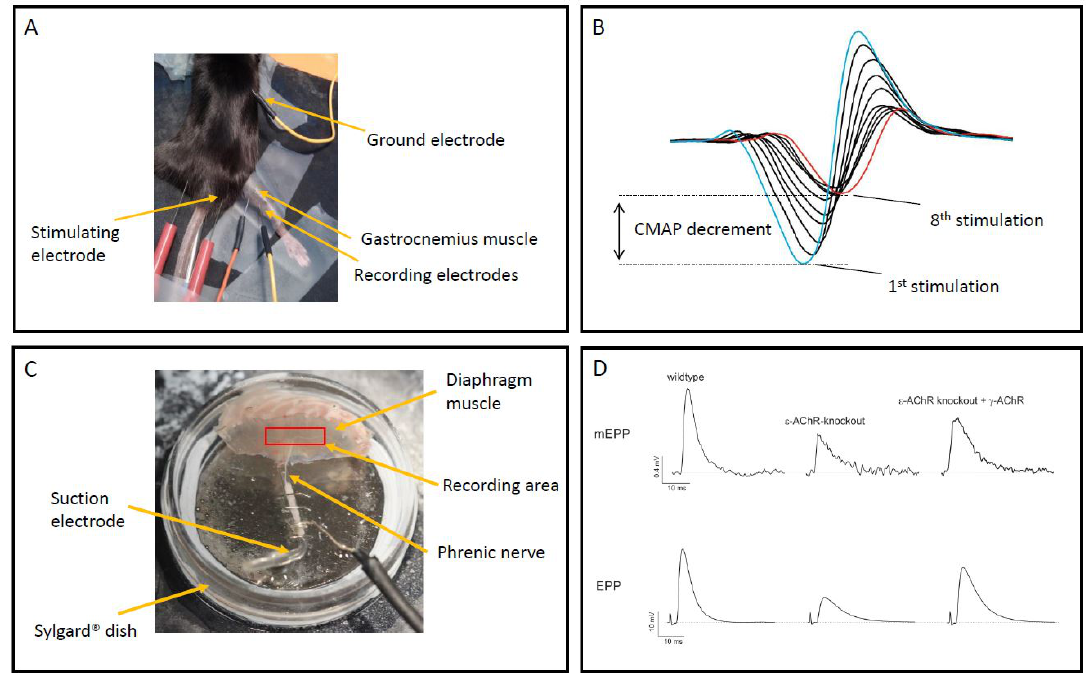
Figure 1. Panel ( A ) shows experimental setup for in-vivo electromyography of anaesthetised mouse, with location of stimulating and recording mono-polar needle electrodes. Panel ( B ) shows example trace of compound muscle action potential (CMAP) recorded for gastrocnemius muscle, significant decrement is evident between 1st and 8th stimulation at 10 Hz. Panel ( C ) shows experimental setup for sharp electrode recording from ex-vivo mouse phrenic nerve/hemi-diaphragm muscle, central area surrounding phrenic nerve branch within muscle where recordings are acquired is indicated. Panel ( D ) shows examples of miniature endplate potentials (mEPPs) and stimulated endplate potentials (EPPs) recorded from an 8-week-old wildtype mouse, an ε -AChR knockout mouse and an ε -AChR knockout mouse with human γ -AChR knocked-in. ε -AChR knockout mice have severely reduced mEPP and EPP amplitude due to diminishing post-natal expression of γ -AChR containing receptors with no adult AChR expression, knock-in of human γ -AChR partially restores mEPP and EPP amplitude and is a model for AChR-deficiency